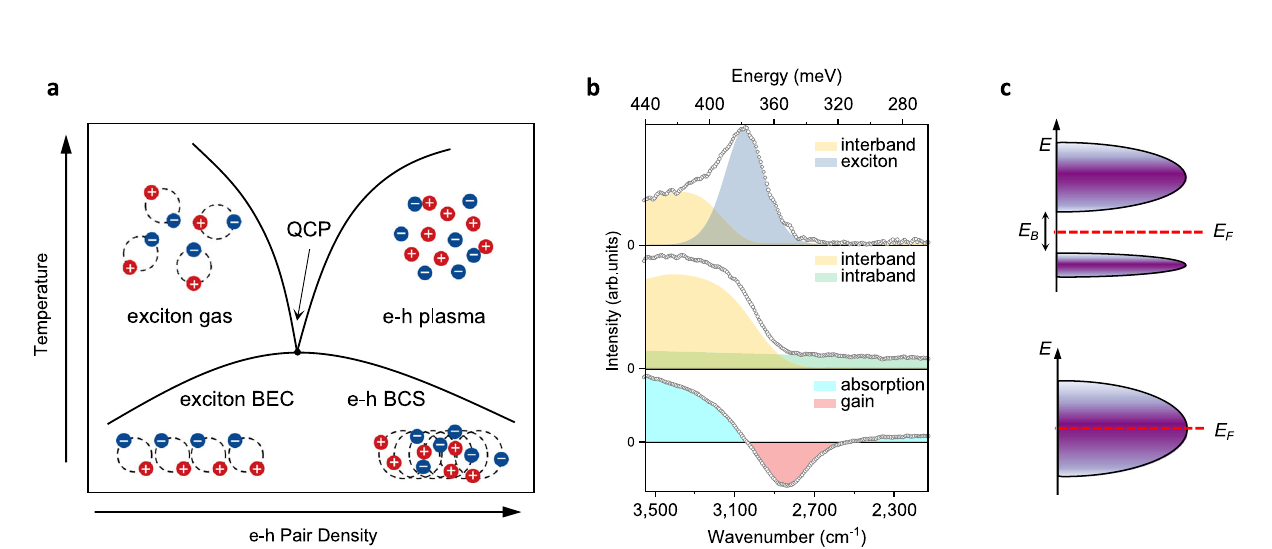
Fig.2|Photo-excitedelectron – holesysteminBP.a Schematicphasediagramfor correlated electron-hole states in the parameter space of temperature and electron – hole (e – h) pair densities. At low density, the electrons (blue circles) pair with holes (red circles) to form exciton phase. At high density, the electrons and holes exist as Fermi liquids at high temperatures. The boundaries are shown in black lines and cross at the quantum critical point (QCP). At much lower tem- peratures, the electron – hole system condenses to exciton Bose – Einstein con- densation (BEC) and the Bardeen – Cooper – Schrieffer (BCS) states depending on the paring strength. b The photocurrent spectra of BP in arbitrary unit (arb. unit).